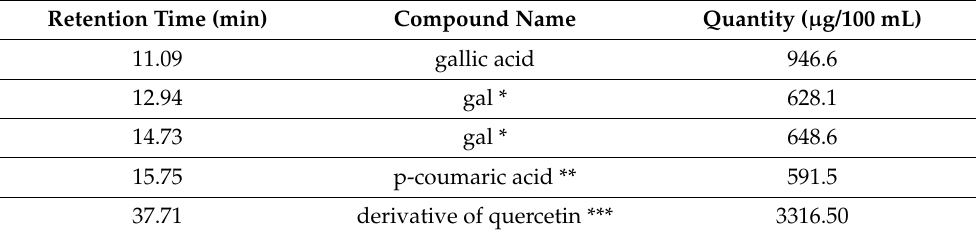
Table 3. Rosa centifolia L. glycolic extract characterization.